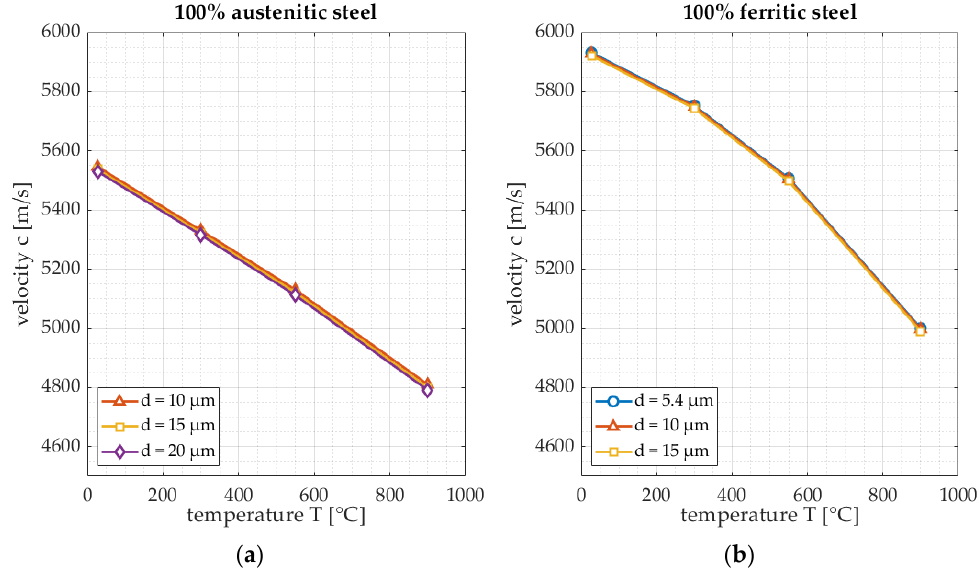
Figure 13. The relation between the temperature 𝑇 , and observed wave velocity 𝑐 for two material types and three grain sizes: ( a ) shows 100% austenitic steel; and ( b ) 100% ferritic steel.